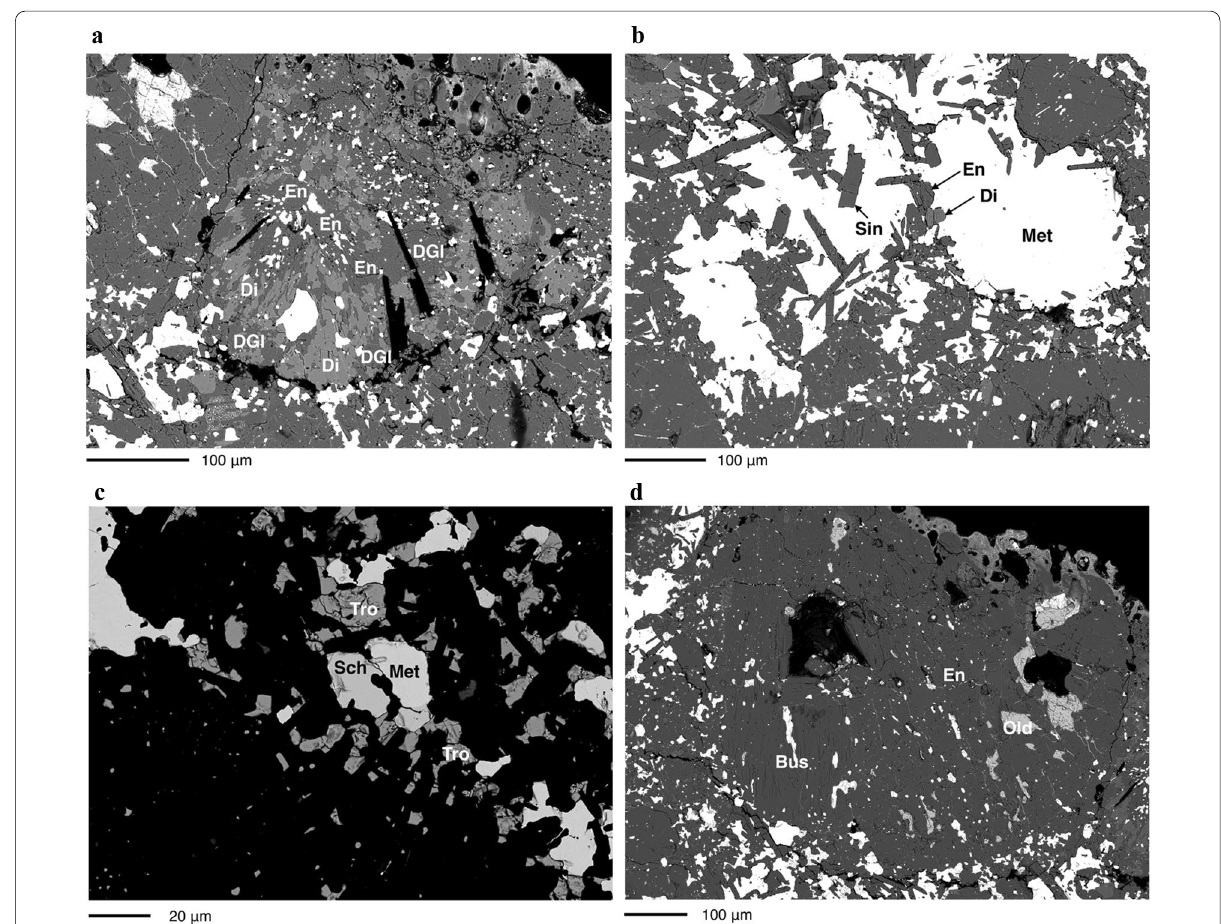
Fig. 2 BSE images of chondrules, an opaque nodule and metal from MS-177: a a chondrule consisting of abundant diopside (Di) with enstatite (En) and devitrified glass (DGl), in close association with abundant Fe–Ni metal (white). Black prismatic void spaces are encountered. b An opaque nodule consisting of Fe–Ni metal (Met) including laths of enstatite, diopside, and sinoite (Sin). c Isolated Fe–Ni metal, troilite (Tro), and schreibersite (Sch). d A chondrule mainly consisting of enstatite with oldhamite (Old) and buseckite